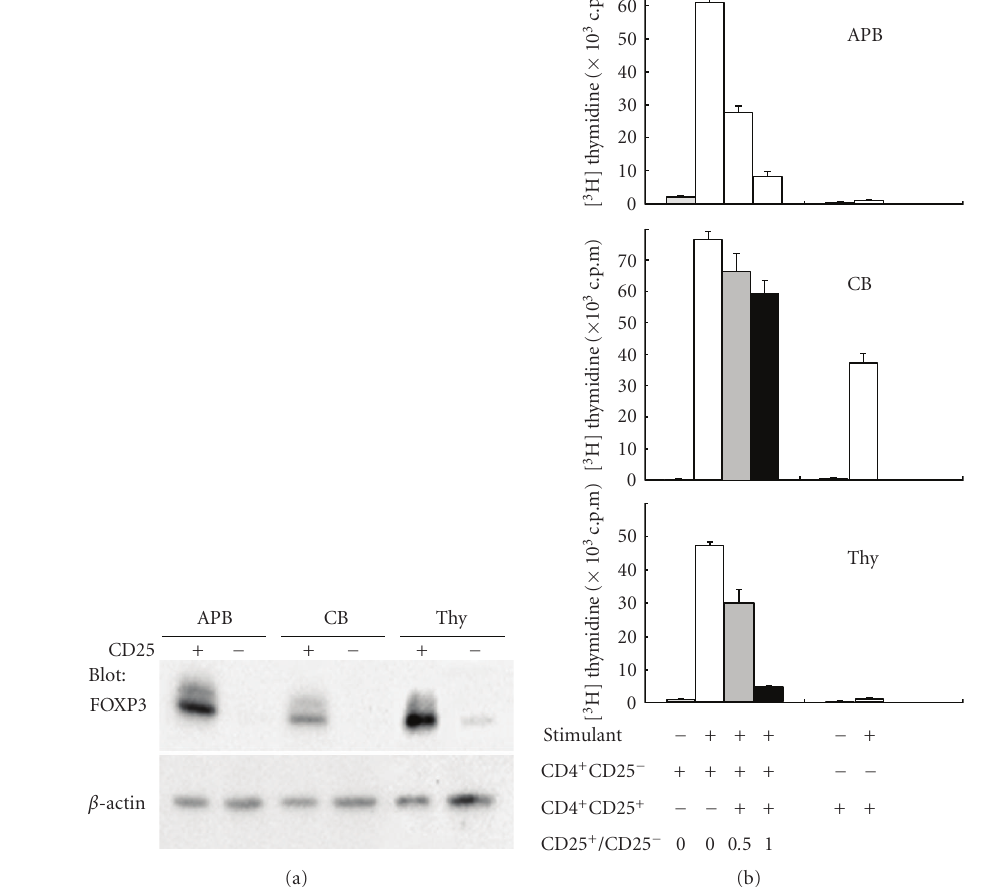
Figure 2: Lack of suppressive activity and absence of an anergic state by CB CD25 + CD4 + T cells. CD4 + CD25 + and CD4 + CD25 − T cells were purified by a magnetic microbead system. (a) Cells were lysed and immunoblotted with anti-FOXP3 Ab (top panel) or anti- β -actin Ab (bottom panel). (b) Cells were stimulated with anti-CD3/CD28-mAb-coated beads under the indicated conditions. Cell proliferation was assessed by 3 H-thymidine uptake on day 4. Data are representative of 5 di ff erent donors.